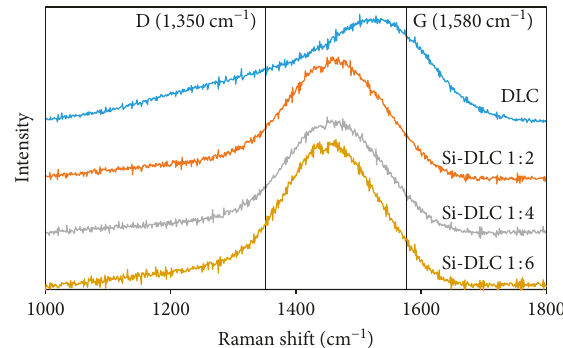
Figure 3: Raman spectra of pure DLC and Si-DLC films at different flow rate ratios.